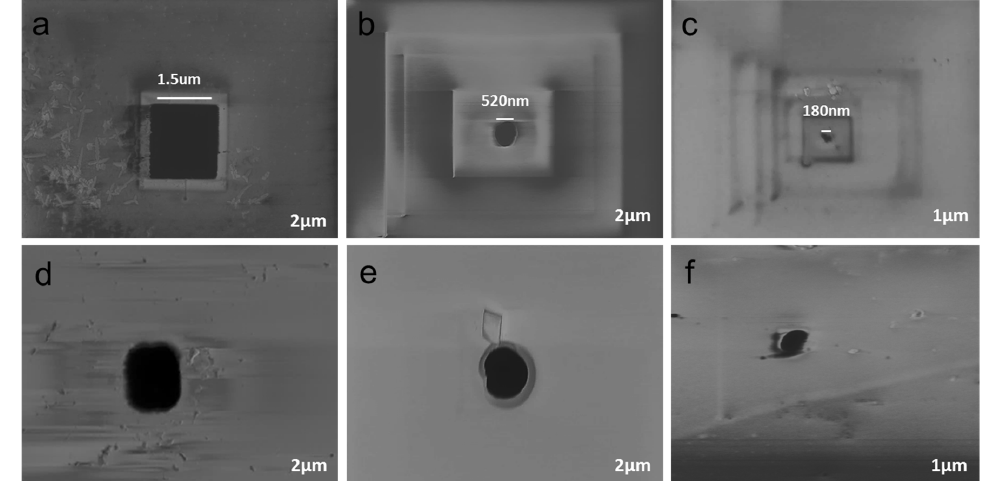
Figure 4. SEM images of fabricated pores in a thin Si membrane. ( a – c ) Front view; and ( d – f ) rear view. ( a , d ) 1.53 ± 0.11 μ m under J = 4.91 mA/cm 2 with 15% HF in an aqueous electrolyte; ( b , e ) 520 ± 35 nm under J = 1.57 mA/cm 2 with 10% HF in an aqueous electrolyte; and ( c , f ) 180 ± 12 nm under 0.47 mA/cm 2 with 5% HF in an aqueous electrolyte.